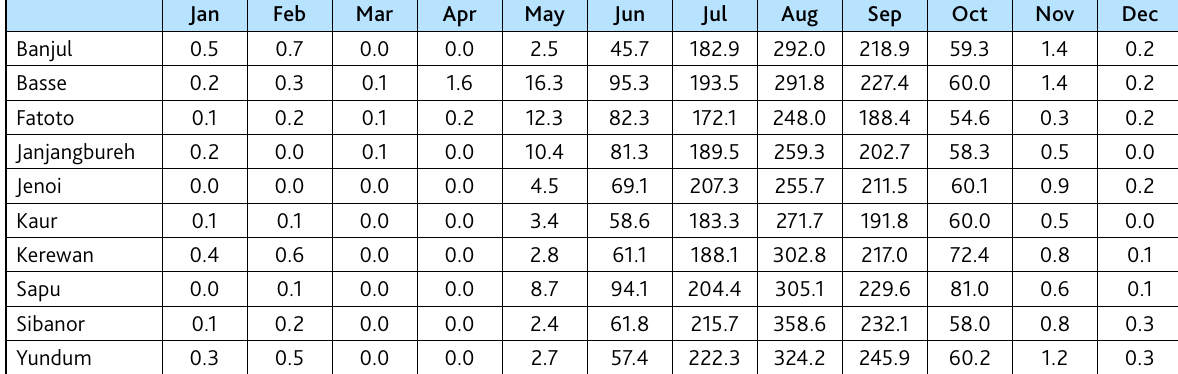
Table 2. Mean monthly Rainfall